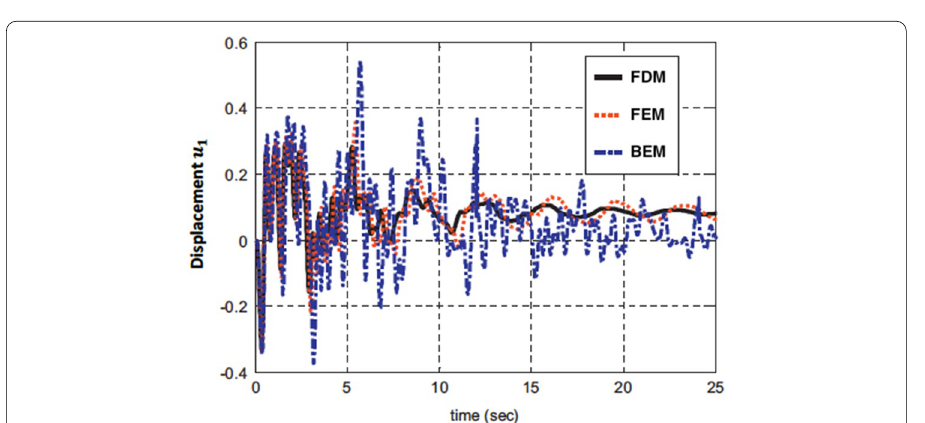
Fig. 10 Variation of the nonlinear displacement u 1 with time τ for FDM, FEM and